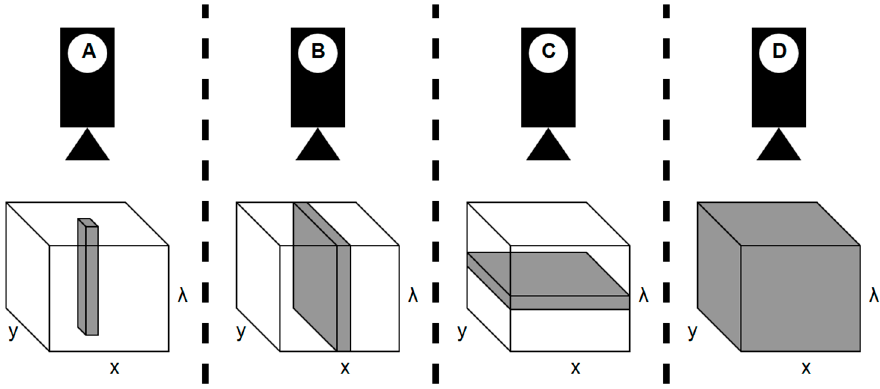
Figure 4 . Hyperspectral data acquisition modes: ( A ) represents point scanning or whiskbroom mode; in ( B ) presents line scanning or pushbroom mode; ( C , D ) correspond to plane (or area) scanning and single shot modes, respectively (adapted from [43]).